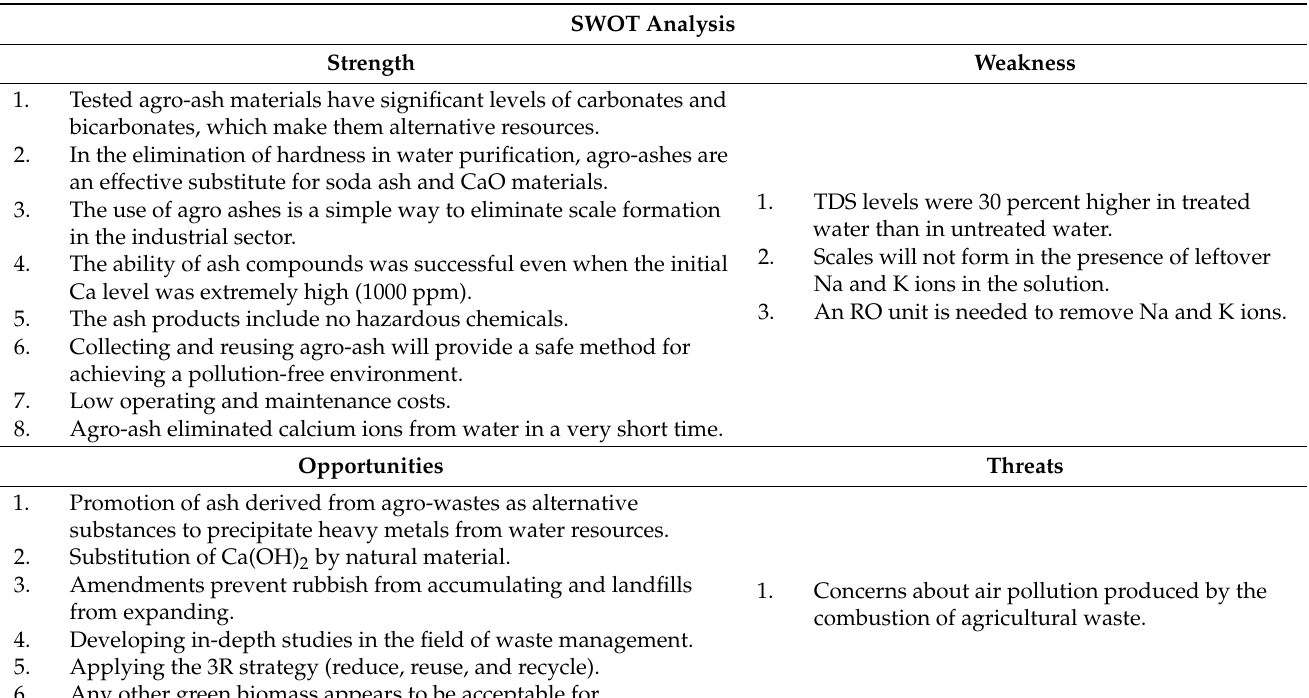
Table 7. SWOT analysis for using green